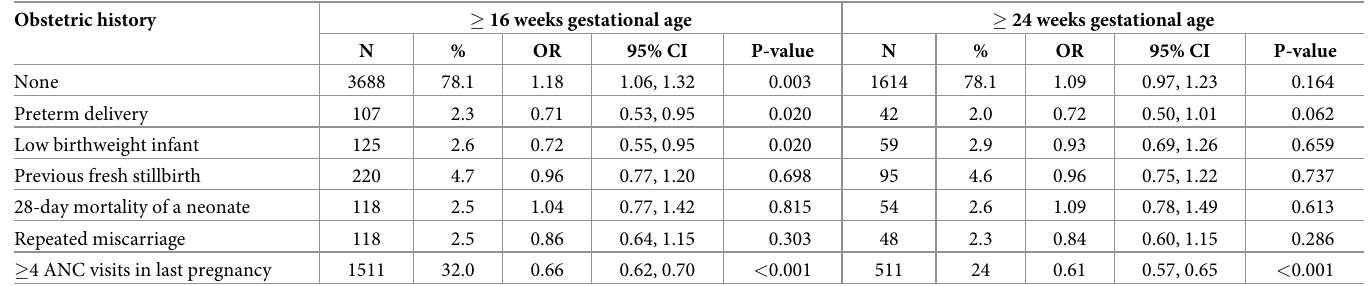
Table 2. Univariate relationships between obstetric history and delayed antenatal